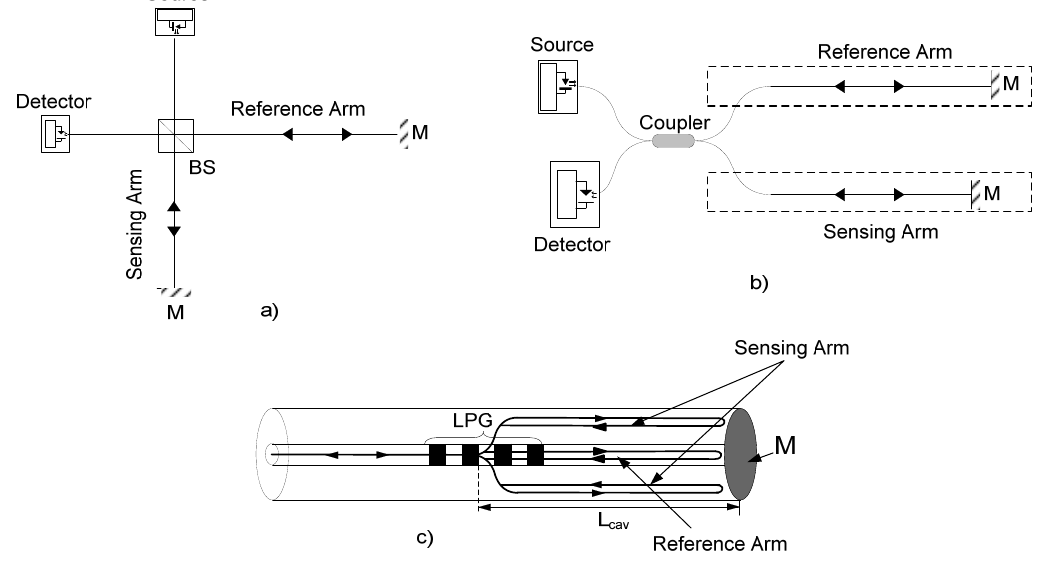
Figure 1. Michelson interferometer: ( a ) bulk; ( b ) optical fiber interferometer and ( c ) in-fiber LPG interferometer. Figure 1 represents the three possible configurations for a Michelson interferomter: (a) represents the classical bulk configuration and consists of a beam splitter and two mirrors placed at right angles relative to each other, both of which are positioned at forty-five degrees to the beam splitter; (b) represents the configuration totally in fiber, the main difference to the bulk interferometer being that the light waves along both optical paths are confined to travel in a single-mode fiber (the fiber optic Michelson interferometer uses a directional coupler (DC) as a beam splitter, and the mirrors on the tips of each fiber provide the necessary reflection); and (c) represents the in-fiber interferometer. In this case, the beam splitter is replaced by an LPG with 3 dB losses.